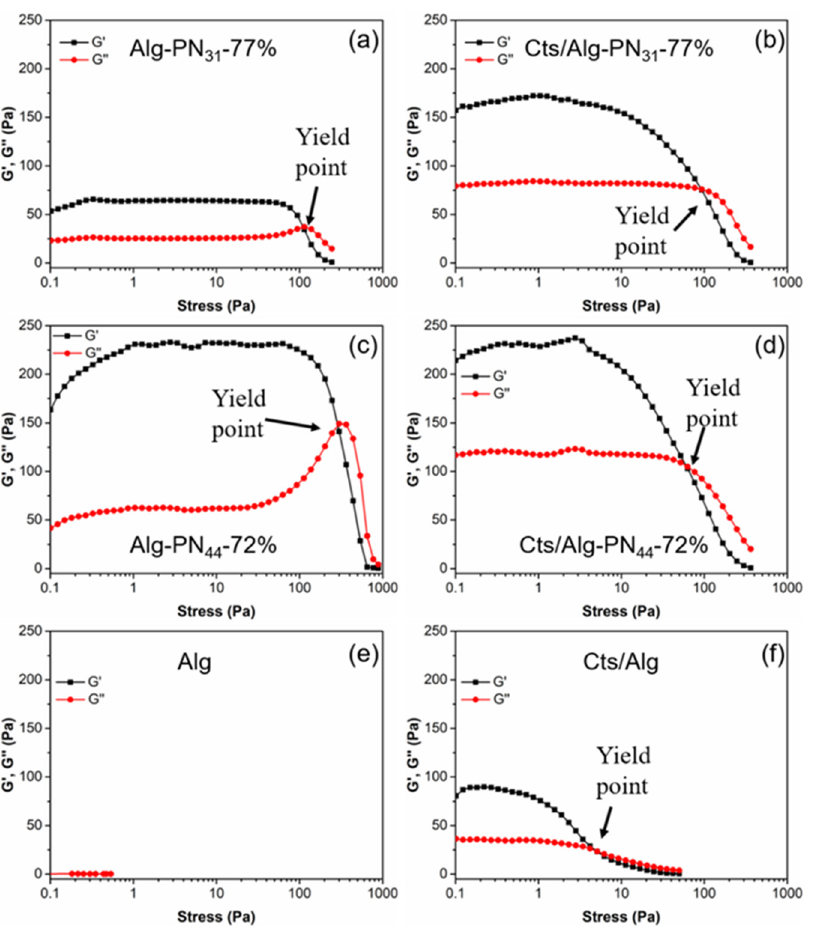
Figure 4. Oscillatory stress sweep measurements of hydrogel samples Alg-PN 31 -77% ( a ), Cts/Alg- PN 31 -77% ( b ), Alg-PN 44 -72% ( c ), Cts/Alg-PN 44 -72% ( d ), Alg ( e ), and Cts/Alg ( f ). The measurements were performed with a constant frequency (1.0 Hz) at 37 °C.